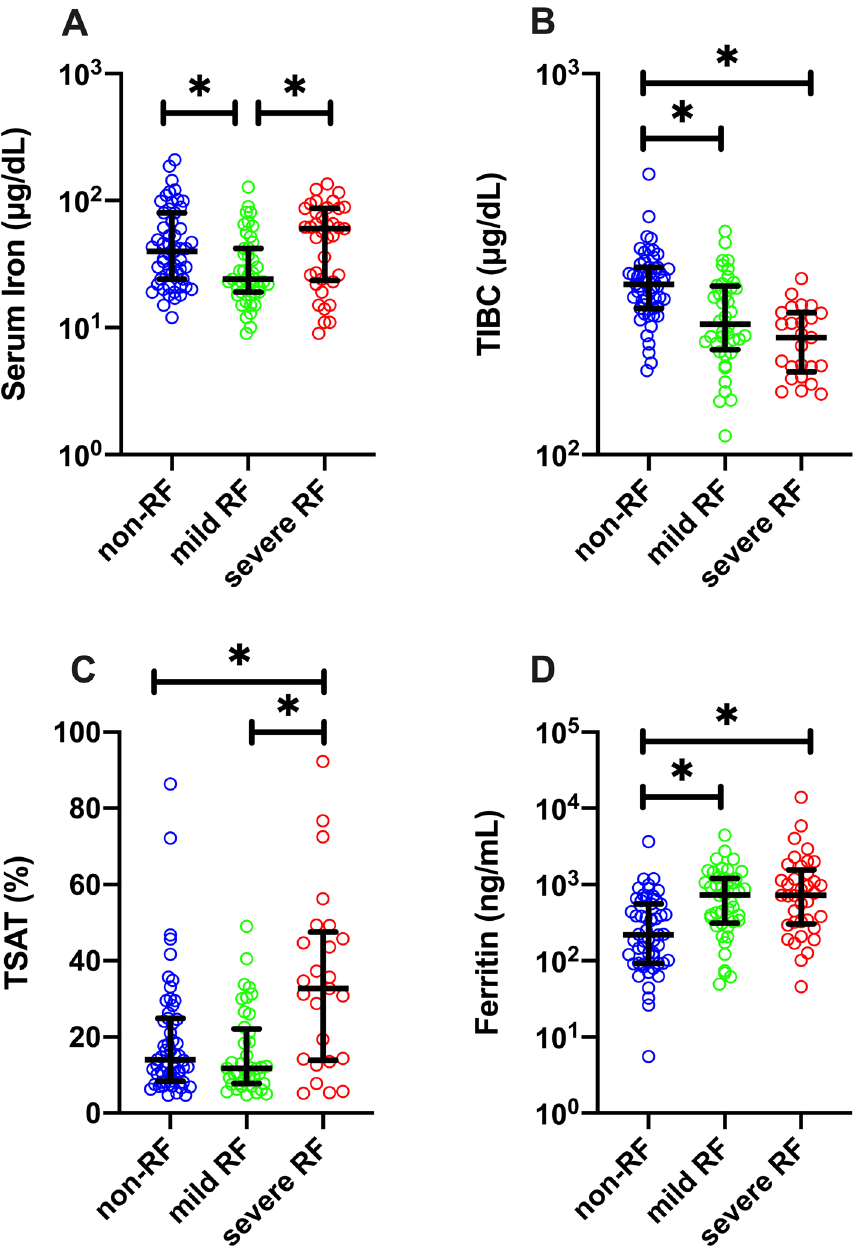
Figure 2. Iron metabolism indicators in hospitalized patients with COVID-19. ( A ) serum iron, ( B ) total iron- binding capacity (TIBC), ( C ) transferrin saturation (TSAT), and ( D ) ferritin levels. All the values were measured within the first 5 days of hospitalization. Data are presented as median ± interquartile range (IQR). *p <